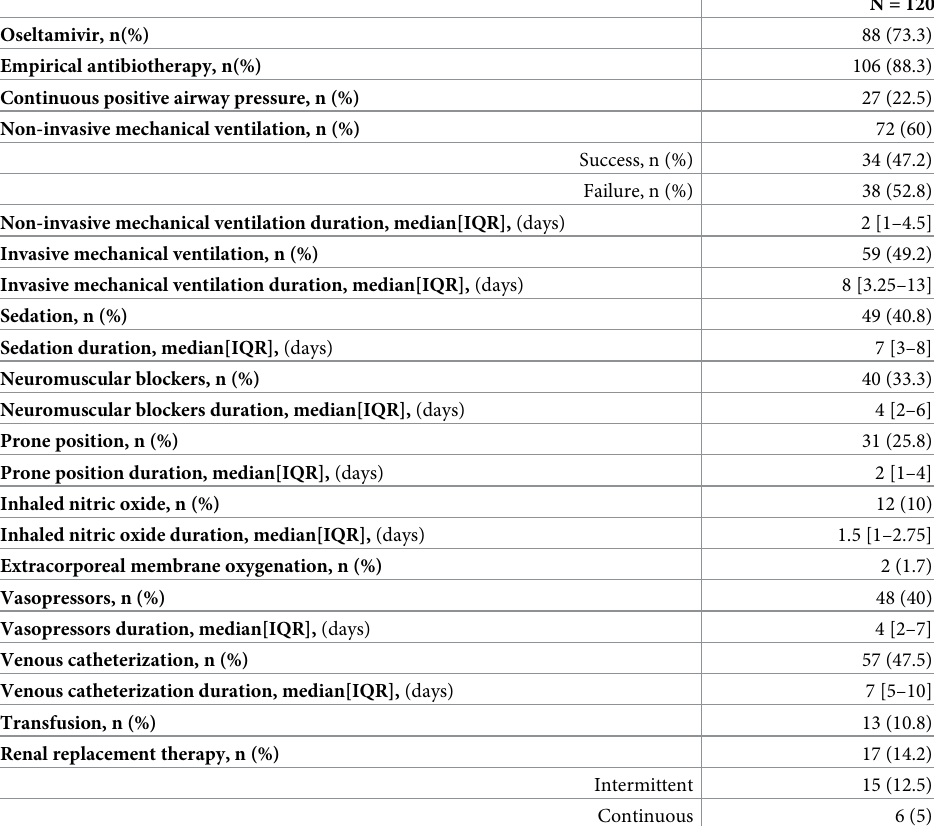
Table 2. Management requirements during ICU stay of 120 ICU patients with influenza